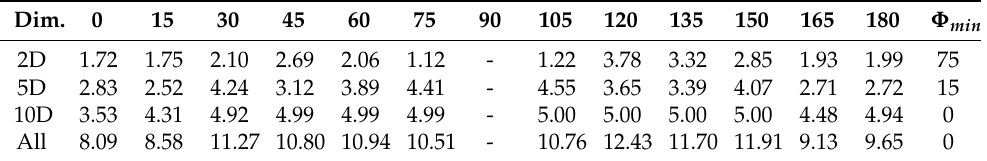
Table 3. Mahalanobis distances between the 90 ◦ rotated image set and every other rotated augmenta- tion set in the C-band latent space. Two-dimensional distances are calculated using the coordinates in Table 2, and a similar procedure is used for 5D and 10D representations. The All dimension sums the distances from 2D, 5D, and 10D. The far right column lists the closest rotation angle ( Φ min ) to 90 ◦ . Dim.